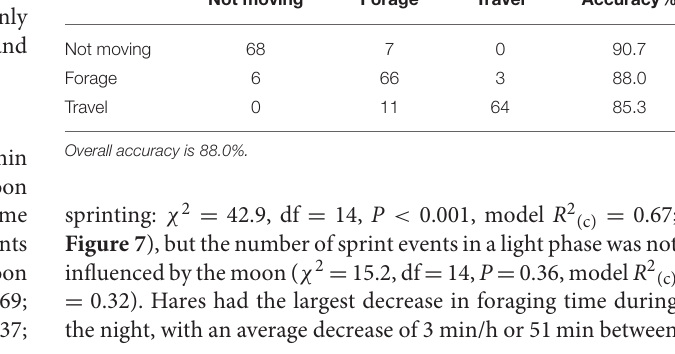
hare behavior to three categories: not moving, forage, and travel. Not moving